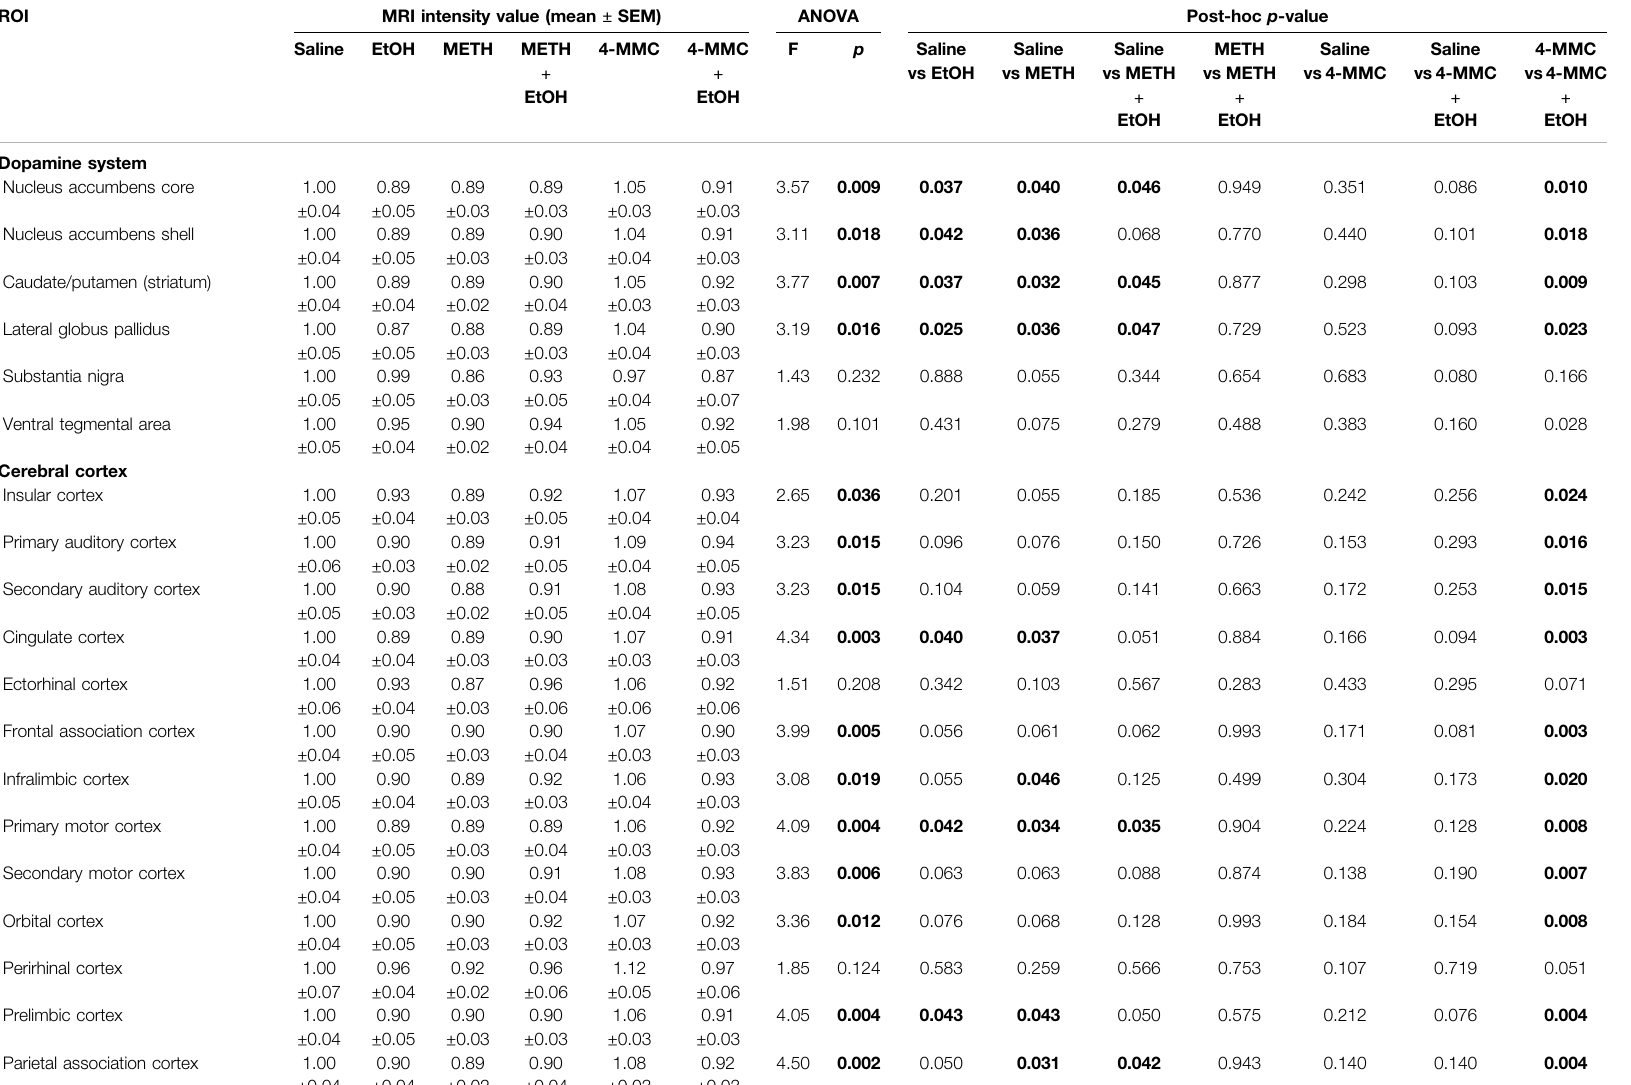
TABLE 1 | Effects of METH and 4-MMC alone or in combination with EtOH on magnetic resonance imaging signal intensity in pre-de fi ned ROIs, two weeks following the last dose of the binge treatment regimen. The mean intensityvaluesineachROIwerenormalized(saline (cid:1) 1).Alldataareexpressedasmean ± SEM. N (cid:1) 8pergroup.Signi fi cant p values( p < 0.05)aremarkedbyboldedtext.Onlysigni fi cant p valueswithANOVAmaineffect are bolded. EtOH, alcohol; METH, methamphetamine; 4-MMC, 4-methylmethcathinone; ROI, region of interest; SEM, standard error of the mean.